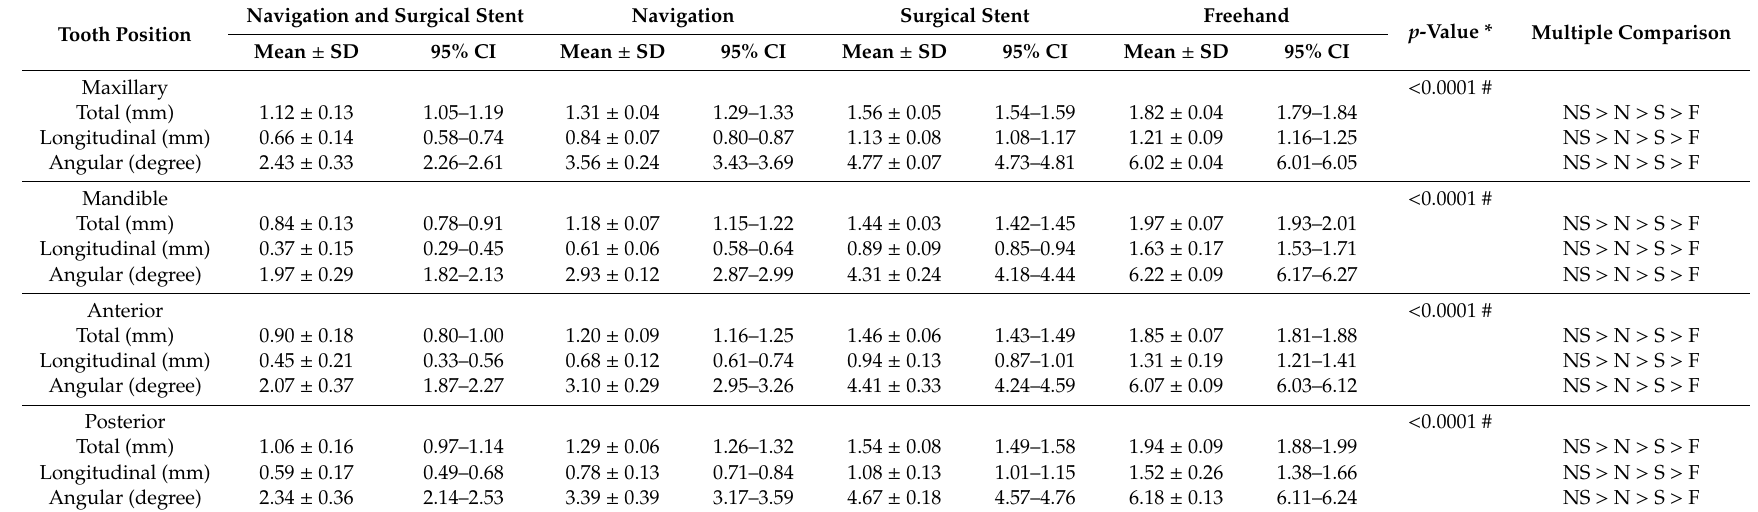
Table 3. The deviation of the total, longitudinal, and angular errors in four surgical approach by di ff erent jaw and dental